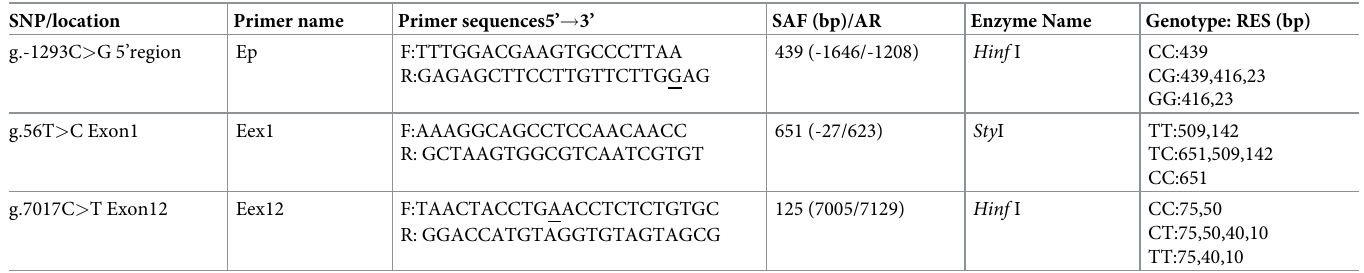
Table 2. PCR primers and PCR–RFLP tests for genotyping SNPs detected in the bovine C3